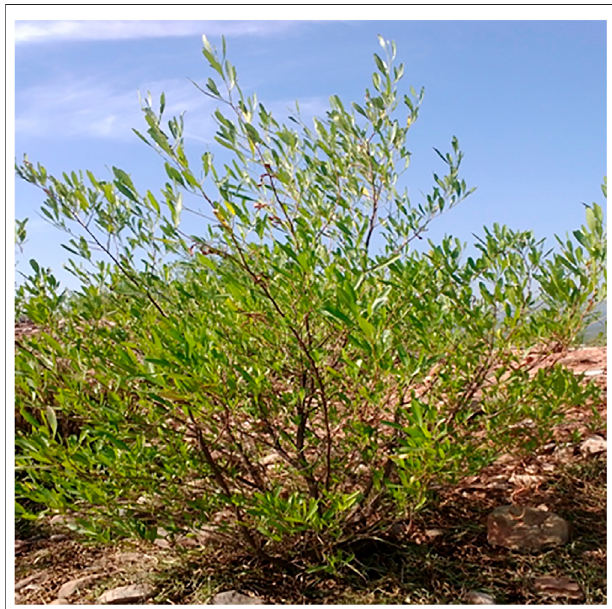
FIGURE 1 | Matured plant of dodonaea ( Dodonaea viscose